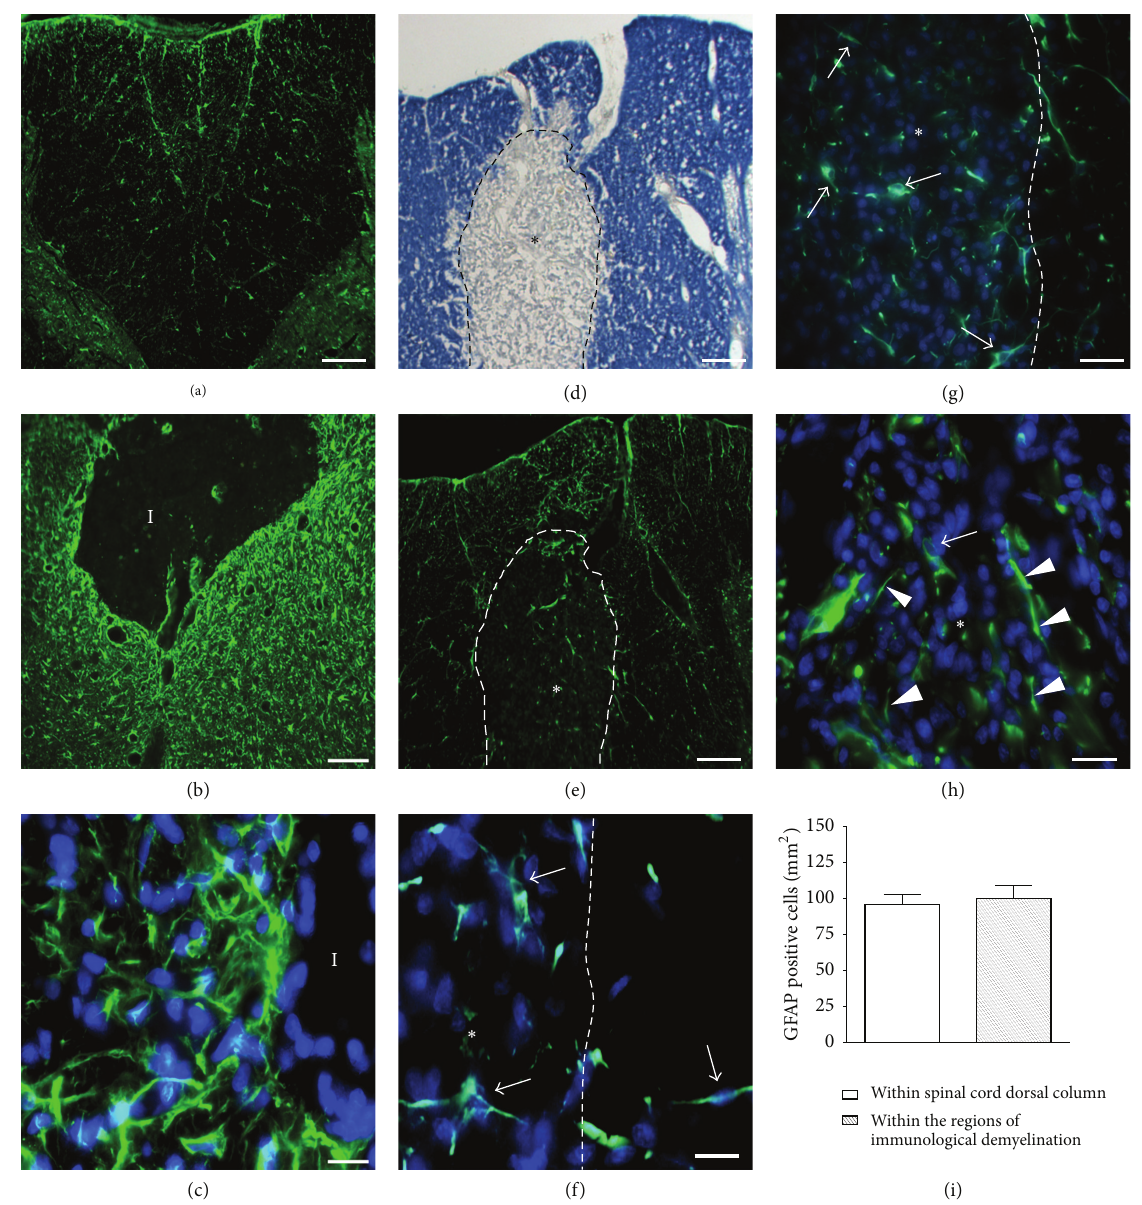
Figure 1: Comparison of the expression of GFAP 7 days after a spinal cord stab injury to the dorsal column or after an injection of GalC antibodies plus complement proteins to the dorsal column. (a) The intensity of GFAP (green) immunoreactivity is low in the uninjured spinal cord dorsal column. (b) A dense ring of reactive astrocytes with intense GFAP (green) expression is evident surrounding the lesion “I.” (c) Higher magnification of the lesion edge: the double staining for GFAP and Hoechst reveals many reactive astrocytes tightly juxtaposed each other. (d) Eriochrome cyanine R staining showing the region of immunological demyelination. (e) GFAP (green) staining of a serial section to (d). (f) Higher magnification view within the region of demyelination showing double staining of GFAP (green) and Hoechst (blue). Note the presence of GFAP positive astrocytes (arrows) close to the edge of immunological demyelination region (white ∗ ). (g) GFAP positive astrocytes (arrows) deeper within the region of demyelination. Note the absence of reactive astrocytes at the border zone between normally myelinated and demyelinated area. (h) Higher magnification within the region of demyelination: the double staining for GFAP and Hoechst reveals an astrocyte (arrow) and multiple intermediate GFAP filaments (arrow heads). (i) The numbers of GFAP-positive cells within regions of immunological demyelination were similar compared to those within regions of normal dorsal column. Scale bars: (a) and (b) 100 𝜇 m; (d), (e), and (g) 50 𝜇 m; (c), (f), and (h) 16.6 𝜇